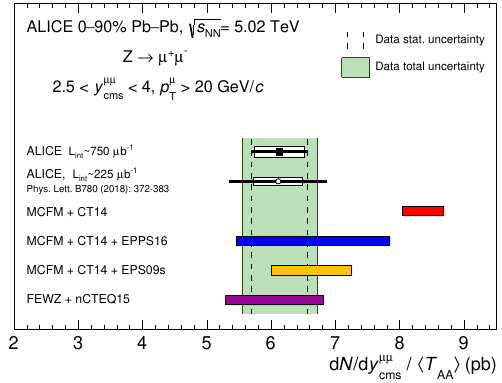
Figure 3 . Invariant yield of Z ! (cid:22) + (cid:22) (cid:0) divided by h T AA i in the rapidity range 2 : 5 < y (cid:22)(cid:22) < 4 : 0 cms p measured in Pb-Pb collisions at s NN = 5 : 02 TeV in the centrality class 0{90%. The vertical dashed band represents the statistical uncertainty of the data while the green (cid:12)lled band corresponds to the quadratic sum of statistical and systematic uncertainties. The result is compared with the previous ALICE result in the same collision system (the data of the earlier result are included in this analysis) [20] , with CT14 [50] free-nucleon PDF calculation and with several NLO pQCD calculations including nuclear modi(cid:12)cation of the